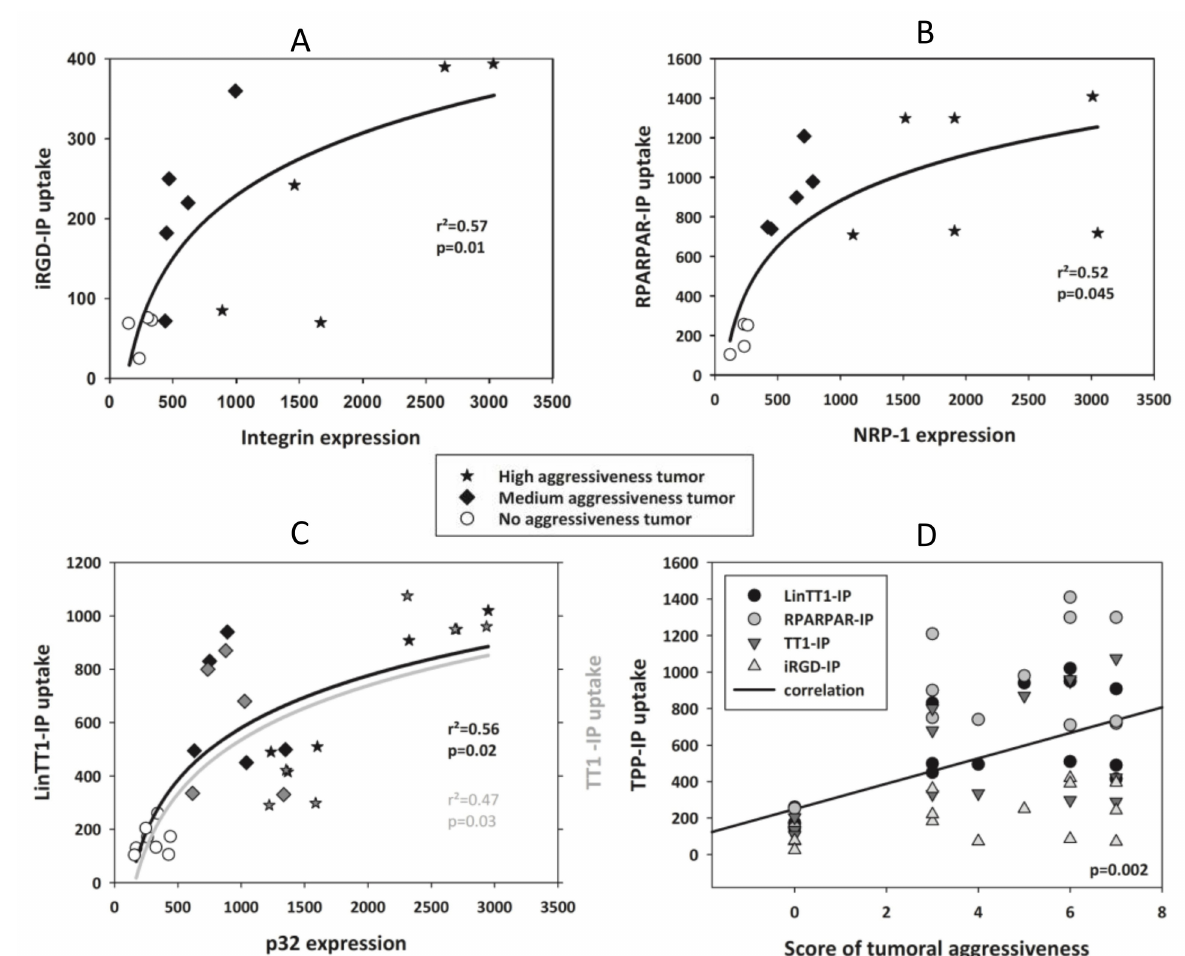
Figure 5. Correlation between receptor expression, peptide internalization, and aggressiveness of HCC. Correlation between integrin expression and internalization of iRGD-IP followed the equation: y = b0 + b1 × log(x). White circle: non-malignant tumor or normal hepatocytes; black squares: samples from medium aggressiveness tumors; black stars: samples from high aggressiveness tumors. ( A ) Integrin expression and iRGD-IP internalization, (b0 = − 610 ± 207, b1 = 121 ± 31) ( B ); NRP-1 expression and RPARPAR-IP internalization, (b0 = − 1344 ± 600, b1 = 322 ± 89) ( C ), p32 expression and internalization of LinTT1-IP (b0 = − 1456 ± 529, b1 = 294 ± 76) and TT1-IP (b0 = − 1636 ± 665, b1 = 313 ± 96) ( D ) Correlation between score of aggressiveness and TTP-IP internalization (r = 0.479, standard error of estimate = 333.2, f = y0 + a × x with y0 = 249 ± 83, a = 69.7 ±